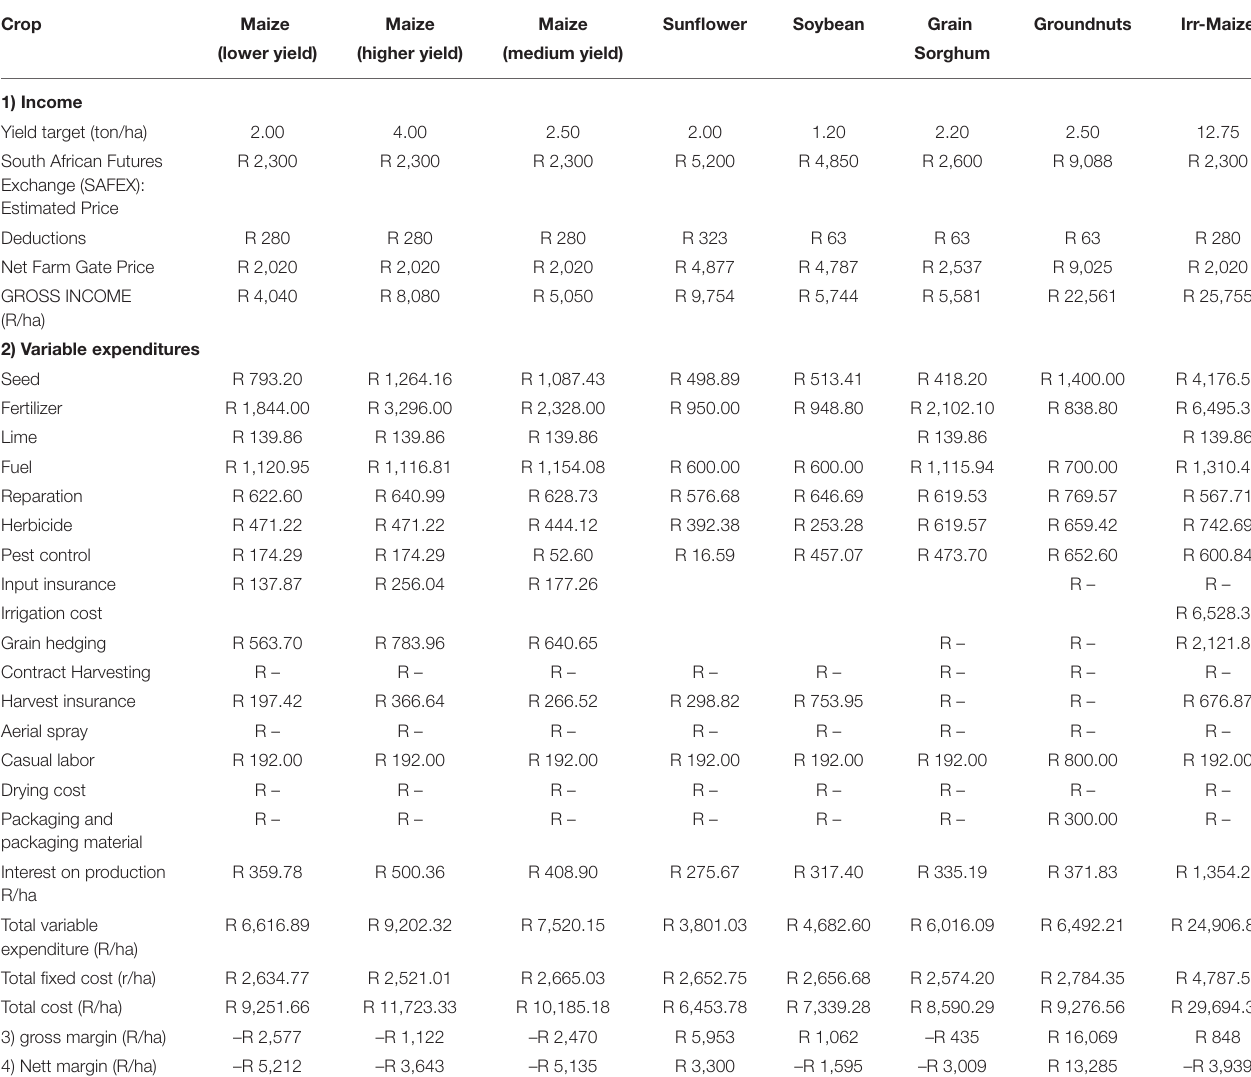
TABLE 1 | Cost analysis for selected summer crop production in Limpopo Province. Average cost budgets for production of selected summer crops cultivation for the period 2014 – 2018 Crop Maize Maize Maize Sunflower